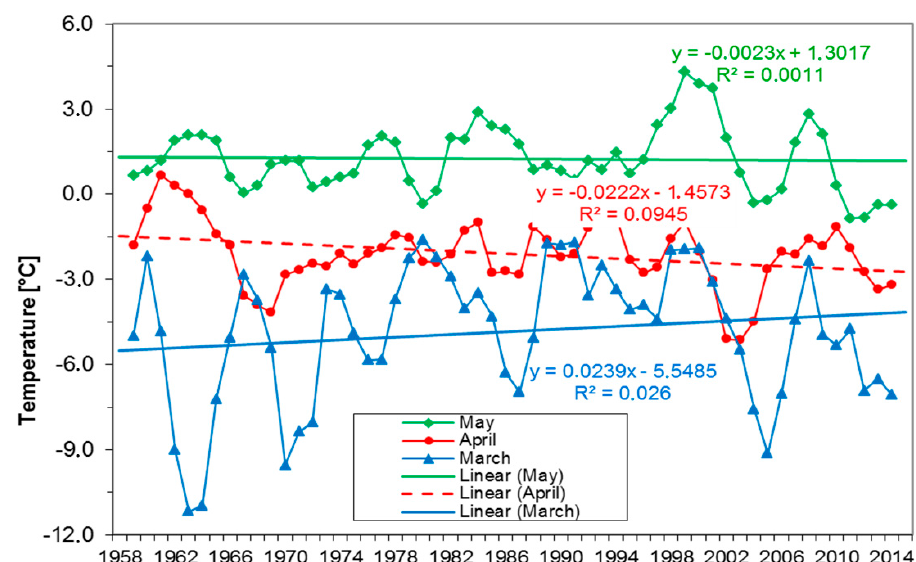
Figure 4. Averaged monthly minimum temperature (Tmin, 30 day average) in March (blue), April (red, dotted line) and May (green solid line) between 1958 to 2017 based on linear curve fitting (with moving averages and R 2 ).